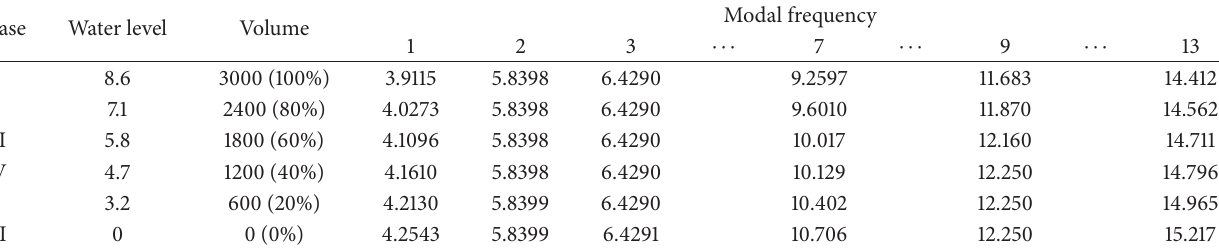
Table 3: The modal analysis results of six different water levels.